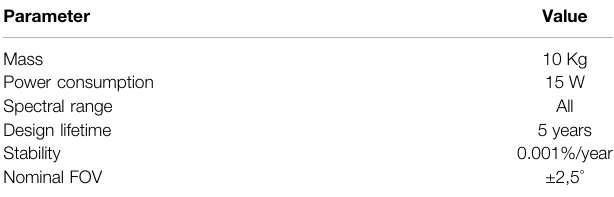
TABLE 3 | IMM main characteristics.